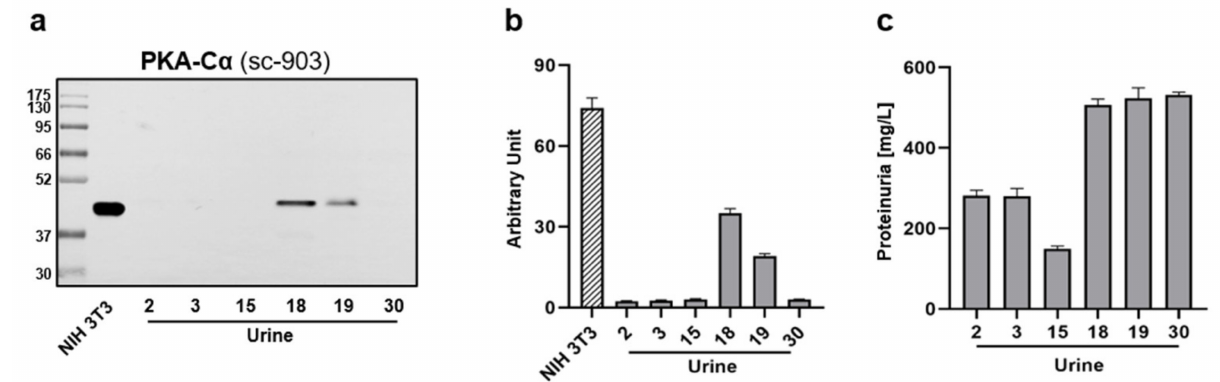
Figure 3. Assessment of PKA-C α levels in human urines. In total, 45 µ L of U2-, U3-, and U30-negative and U15-, U18-, and U19-positive ELISA urine, as well as 10 µ g of NIH 3T3 were examined for PKA-C α levels by WB. ( a ) Representative WB image. ( b ) Densitometric analysis of panel a. ( c ) Protein amount within WB loaded urine samples. Data are shown as average rate ±